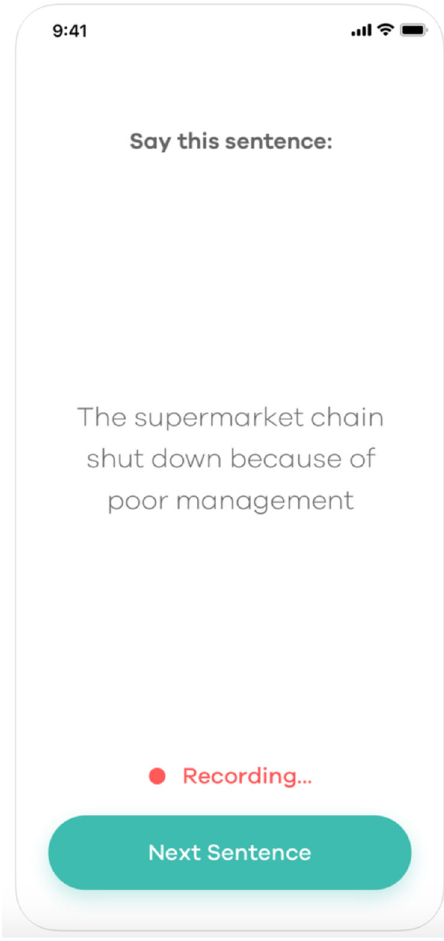
Fig. 3 Screenshot of the mobile application. This fi gure illustrates a sentence from the mobile application used for collecting speech samples.